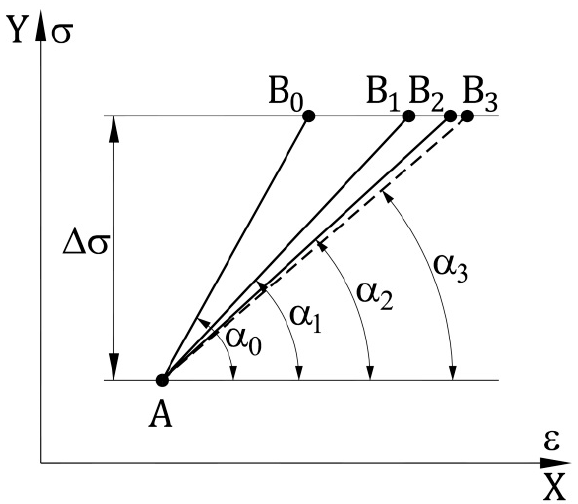
Figure 4. Determining the modulus value in one calculation step.